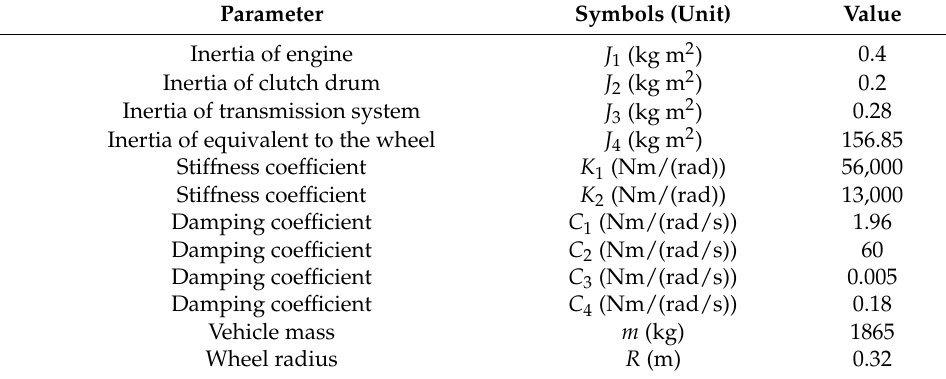
Table 4. Parameters of the